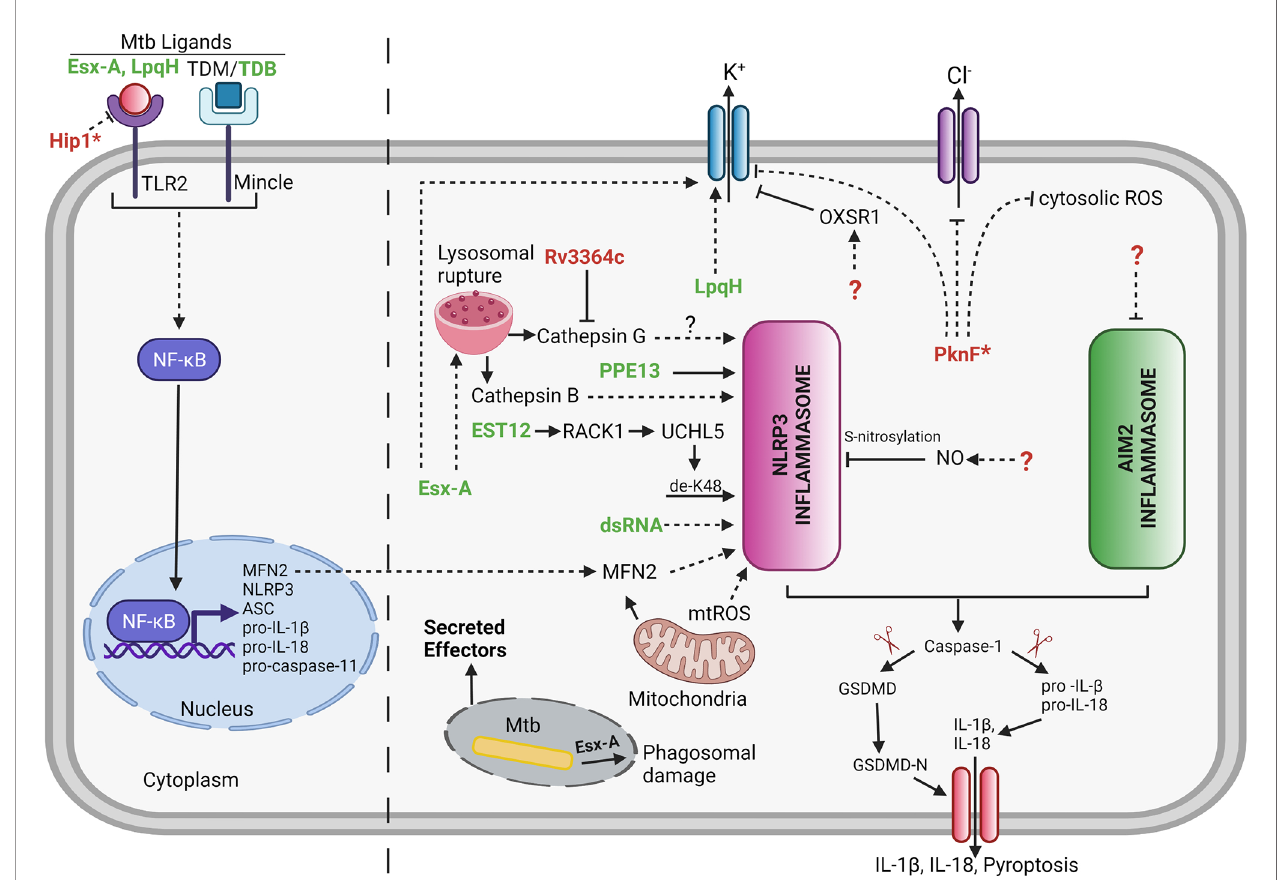
FIGURE 2 | Mycobacterial effectors involved in regulation of host cell in fl ammasome. Several Mtb effectors either secreted or non-secreted (as indicated by *) are known to be implicated in manipulation of the host cell in fl ammasome pathway. Bold green color denotes the Mtb effectors involved either directly or indirectly in activation of in fl ammasome. Bold red color denotes the Mtb effectors involved in inhibition of in fl ammasome. Unknown Mtb effectors are represented by ? (dashed lines = indirect interaction; solid lines = direct interaction; arrowhead = activation; blunt end = inhibition). LpqH,19 kDa Lipoprotein antigen precursor; PPE13, PPE family protein 13; EST12, Estimated 12kDa (Rv1579c); EsxA, 6 kDa Early secretory antigenic target; dsRNA, double stranded Ribonucleic Acid; TDB, Trehalose-6,6- dibehenate; TDM, Trehalose dimycolate; PknF, Protein kinase F; Hip1, Hydrolase important for pathogenesis 1; NO, Nitric Oxide; RACK1, Receptor for Activated C Kinase 1; UCHL5, Ubiquitin C-Terminal Hydrolase L5; MFN2, Mitofusin 2; OXSR1, Oxidative Stress Responsive Kinase 1. Created with